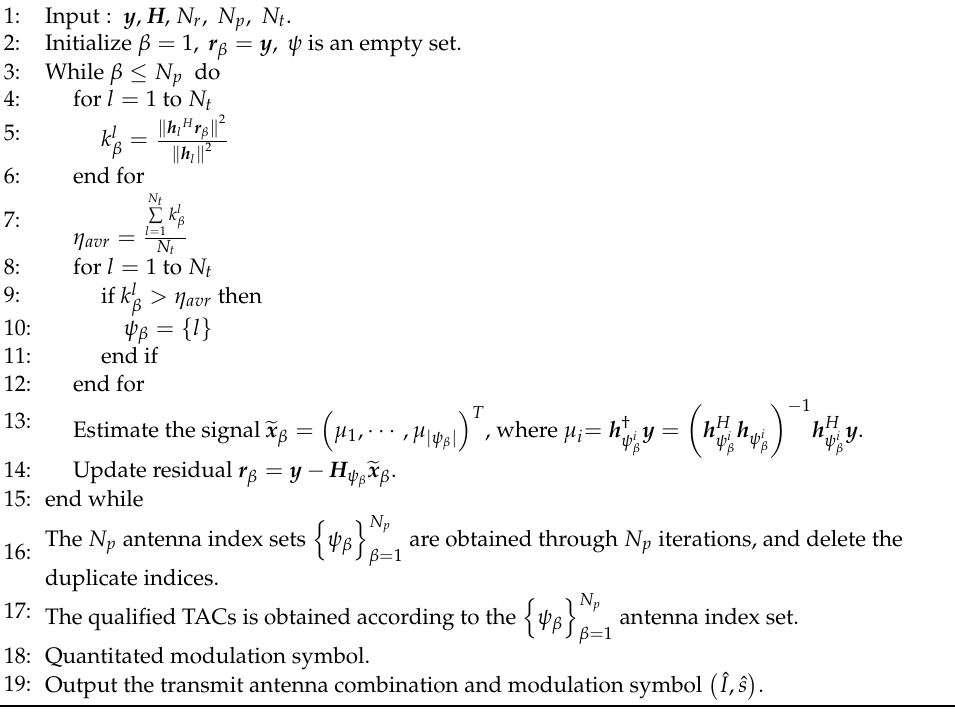
Table 2. Proposed MRC-MP